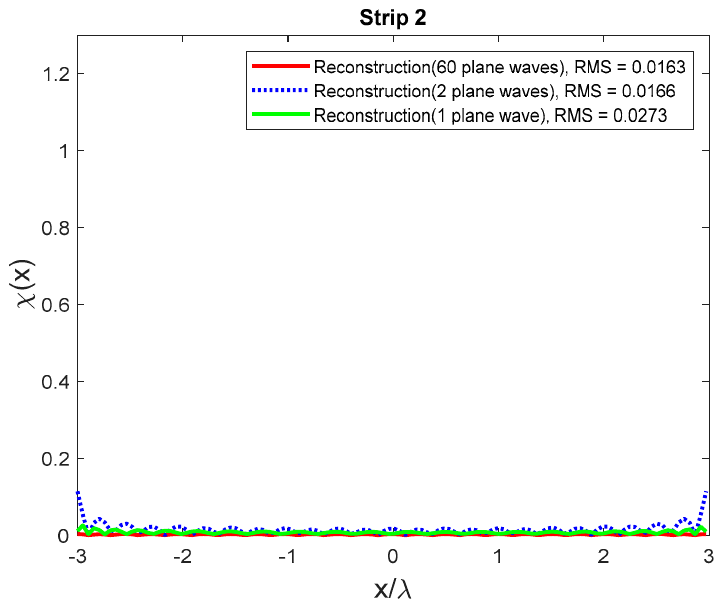
Figure 10. The influence of the reconstruction of the object of Figure 9 on the strip 2 ID .